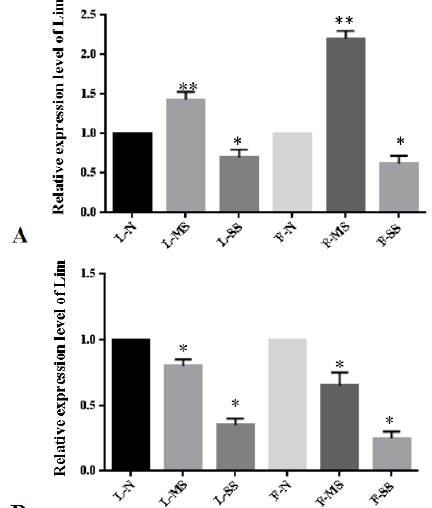
Fig. 1 . The relative gene expression: The expression of the Limonene synthase gene under drought stress condition relative to control condition in leaves and flowers of Ardakan (A) and Taybad (B) ecotypes. L: leaf; F: flower; N: normal irrigated condition; MS: moderate stress; SS: Severe stress.